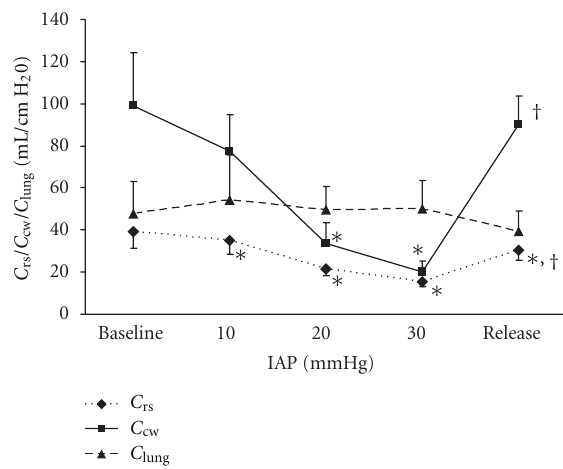
Figure 2: E ff ect of increasing intra-abdominal pressure (IAP) on respiratory system compliance (Crs), chest wall compliance (Ccw), and lung compliance (Clung). Baseline = 6 mmHg, release = 5mmHg. Data are expressed as mean ± SEM. ∗ P = 0 . 04 versus baseline, † P = 0 . 04 versus IAP =